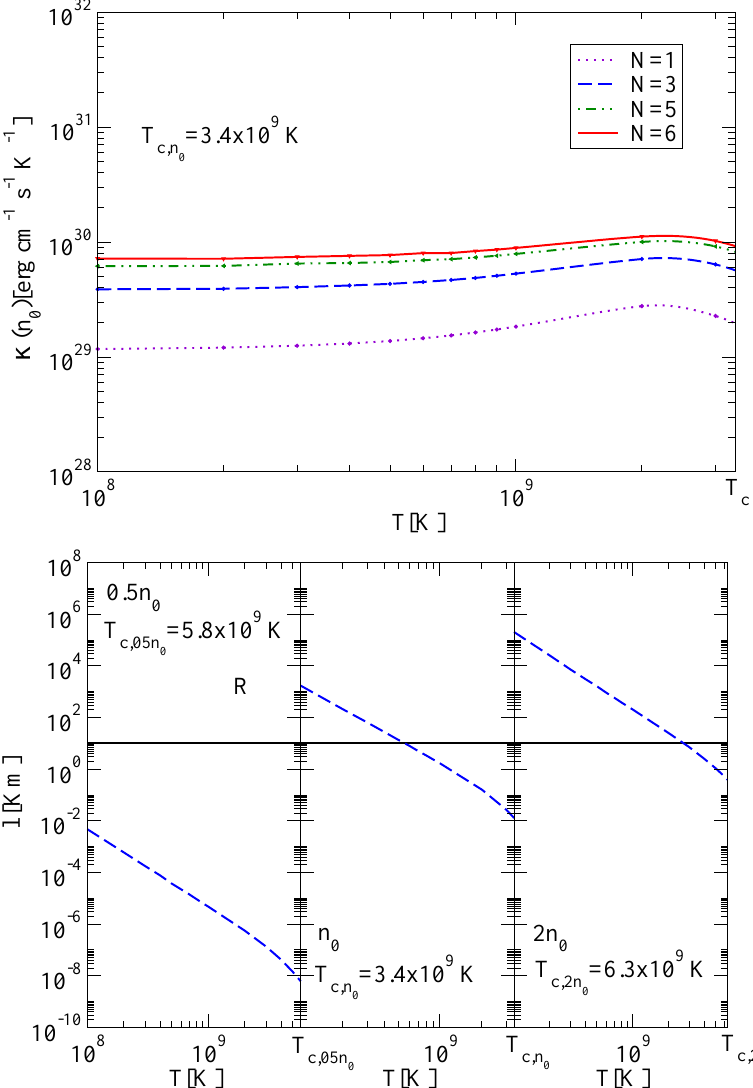
Figure 9. Upper panel : Thermal conductivity due to superfluid phonons by means of a variational calculation up to order N = 6 for n 0 as a function of temperature. We use the 1 S 0 ( A )+ 3 P 2 ( i ) gap model. Lower panel : Mean free path obtained from the phonon thermal conductivity using the 1 S ( A )+ 3 P ( i ) model for the gap as a function of temperature for three different densities. The 0 2 critical temperature shown is T c = 0.57 ∆ , whereas we compare the mean free path to the radius of the star ( R = 10 km). Figures adapted from [9,18]. Adapted from [18] with the permission of AIP